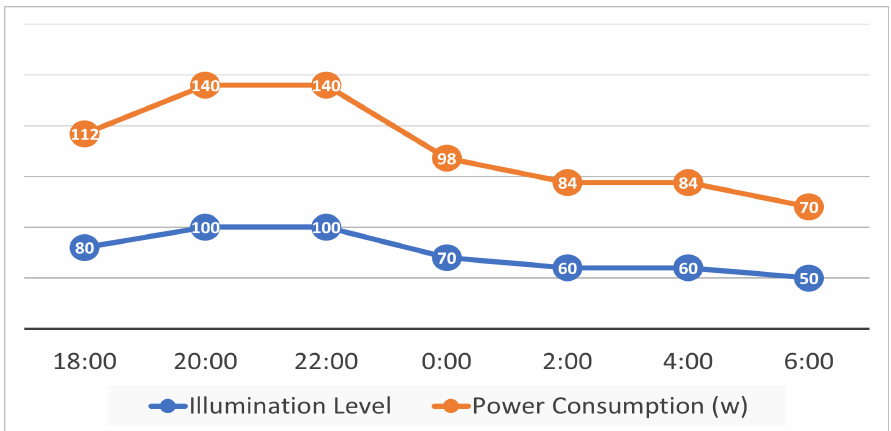
Figure 12. Intensity level and power consumption of streetlights during operational